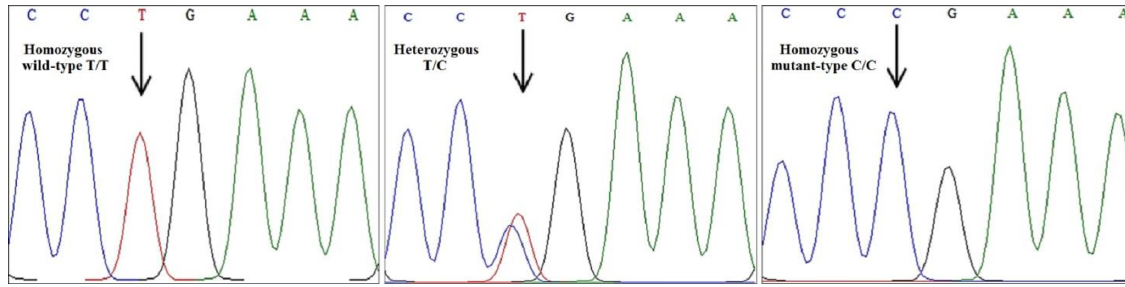
Figure 2. Sequencing results of the T755C mutation in BMP15 in Iranian sheep breeds.